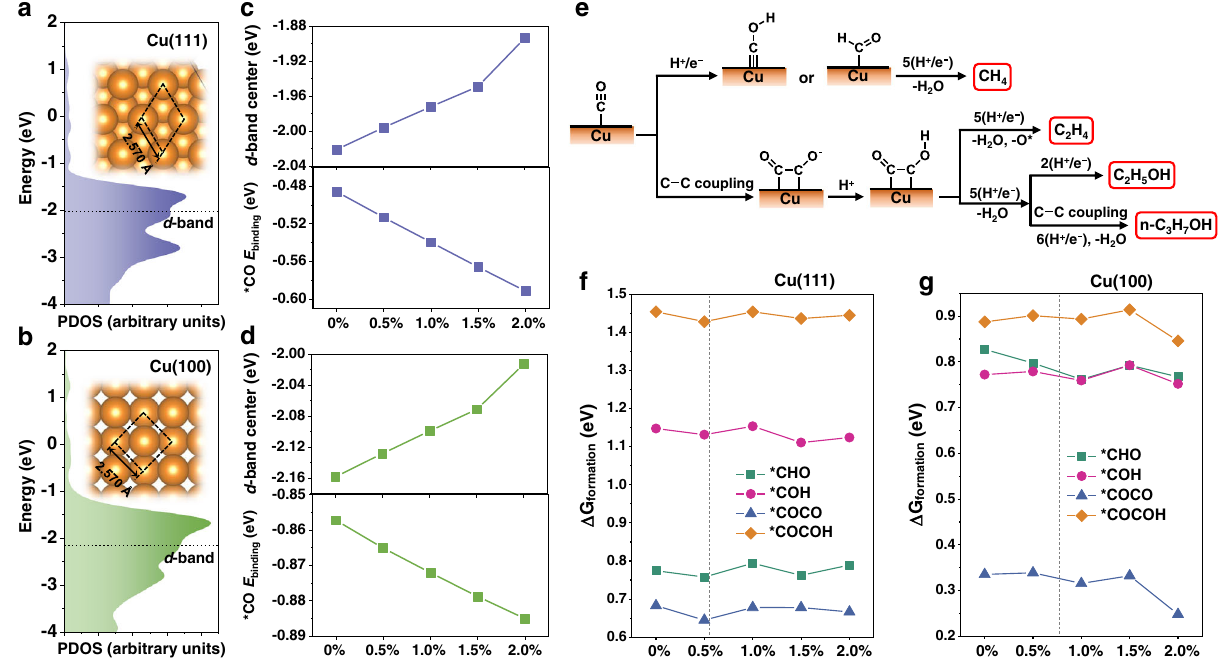
Fig. 6 | The DFT calculation results. Projected density of states (PDOS) of the d - bandfor a Cu(111)and b Cu(100)withoutstrain.Thehorizontalblackdashedlines indicatepositionsofthe d -bandcenter(referencedto theFermilevel).TheFermi level was set as zero. Insets are top views of the corresponding crystal structure slabs. Calculated d -band centers and binding energies of *CO for c Cu(111) and d Cu(100) with different strain values (0.0%, 0.5%, 1.0%, 1.5% and 2.0%). For Cu(111), the *CO coverage is 0.25 monolayer (ML) with a cross-sectional area of